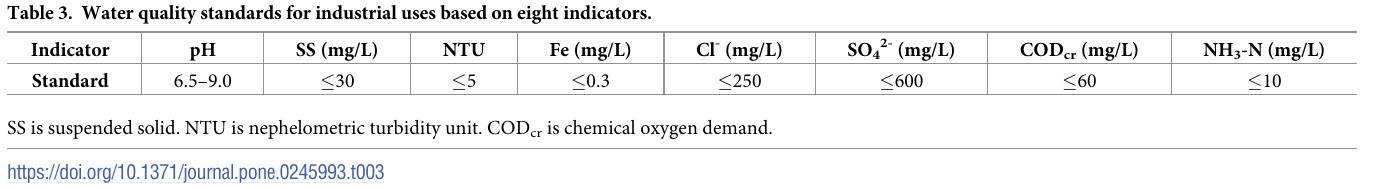
2.3.3 Environmental quality assessment. The single-factor index was used to assess the environmental quality of water resources in the salt marsh area, because the salt marsh area is rich in mineral resources and the water quality is pristine without man-made pollution [54, 55]. Currently, the water resources in this area are mainly used for industrial production processes, including cooling, washing, and supplying of products, and boiler. Here, eight rep- resentative indicators with high detection rates (Table 3) were chosen to assess the environ- mental quality of surface water, by following “The reuse of urban recycling water—water quality standards for industrial uses (GBT 19923–2005)” . Additionally, 10 representative indi- cators with high detection rates (Table 4) were used to assess the water quality of groundwater following the “Standard for groundwater quality (GBT 14848–2017)” .